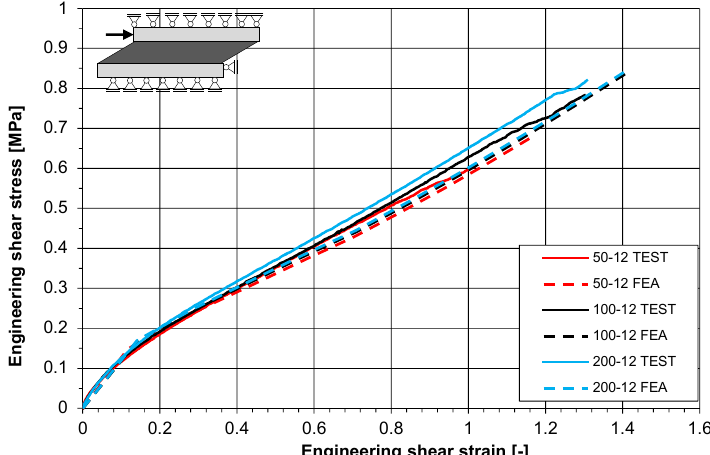
Fig. 21 Experimental and numerical results of the engineering stress-strain curve in shear for the specimen of 12 mm thickness.